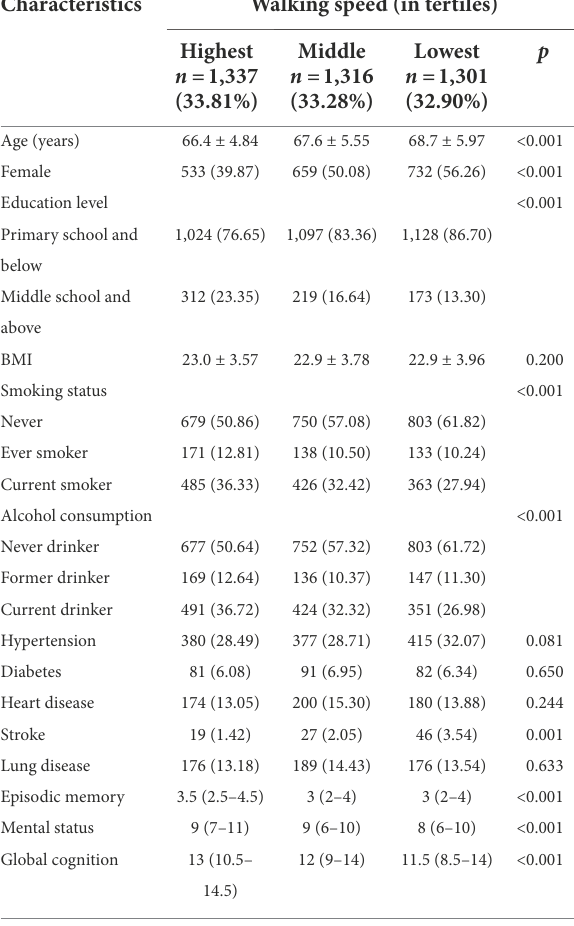
TABLE 1 Baseline characteristics of the study population by walking speed categories ( n = 3,954). Characteristics